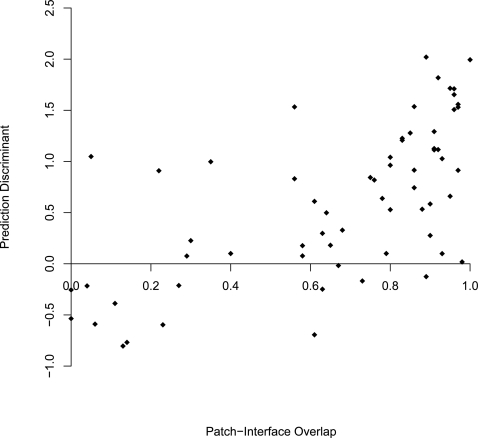
The correlation between the patch-interface overlap and the discriminate value obtained from the SVM classifier.As illustrated, the prediction power of the algorithm depends on the success in identification of the functional interface.